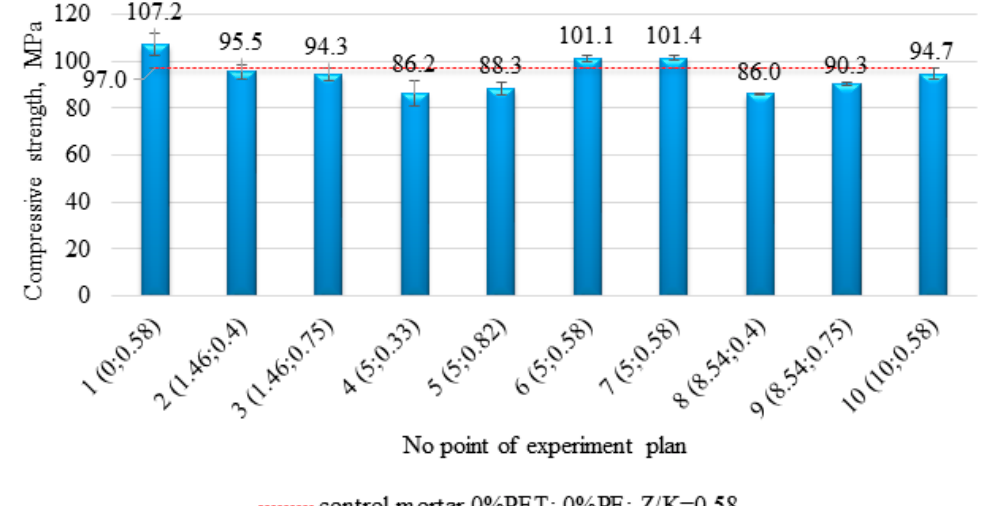
Figure 13. The compilation of the mean compressive strength values for the samples corresponding to each point of the experimental plan.